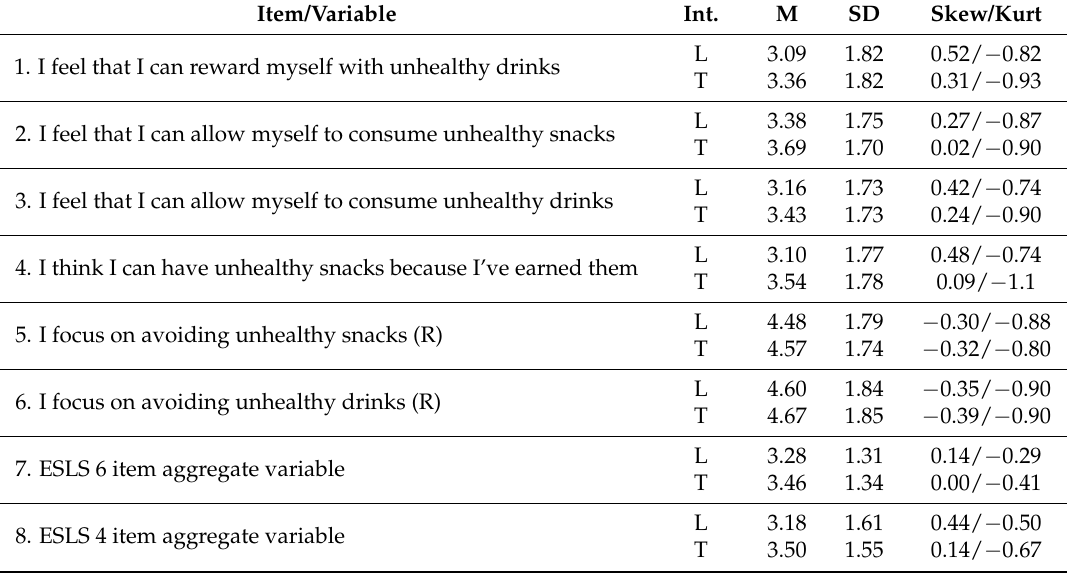
Table 1. Item- and aggregate-level descriptive statistics, and skewness and kurtosis estimates for “light” ( n = 410) and “tiring” ( n = 610) physical activity versions of the Exercise–Snacking Licensing Scale